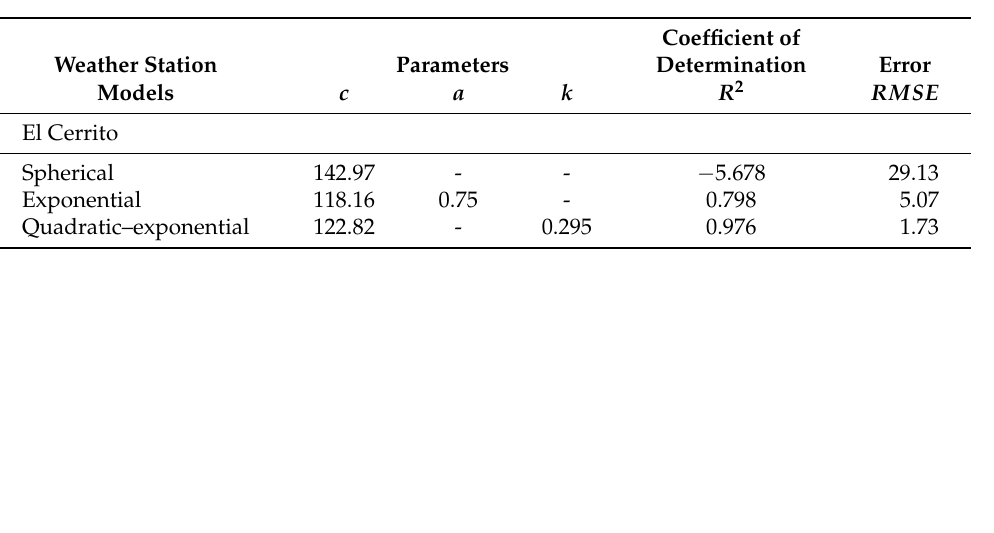
Table 2. Models’ parameters, coefficient of determination R 2 (dimensionless) and root-mean-square error ( RMSE ) (in mm) obtained by fitting each model to each station’s